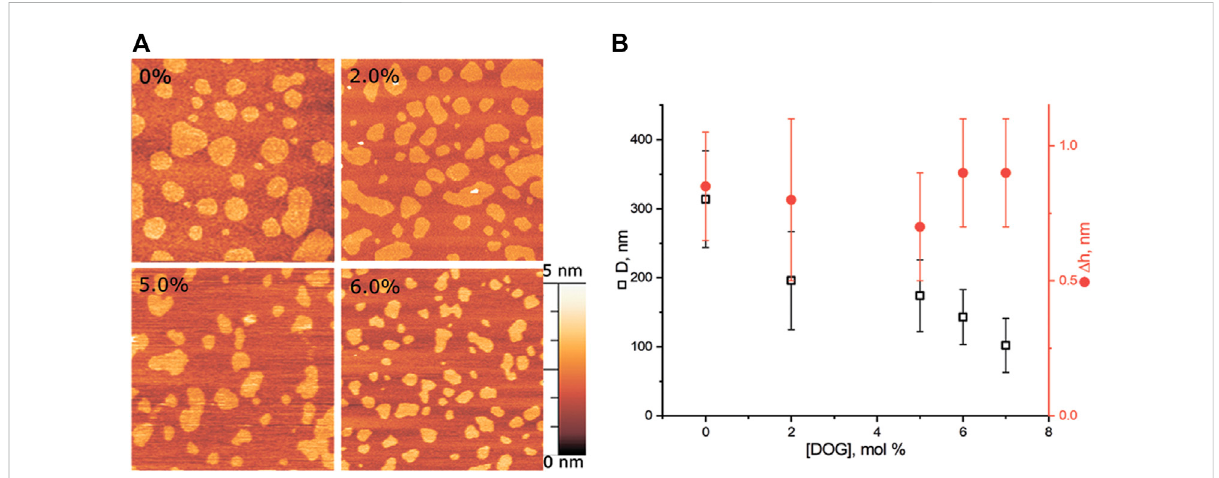
FIGURE 4 DOG in the eSM/DOPC/Chol = 2:2:1 membrane. (A) AFM images of the membrane. Size of each image is 3 μ m × 3 μ m. Amount of DOG in the membrane in mol% is indicated in each image. (B) Dependence of the average diameter of rafts (black) and their height above the surrounding membrane (red) on the molar fraction of DOG in the membrane.